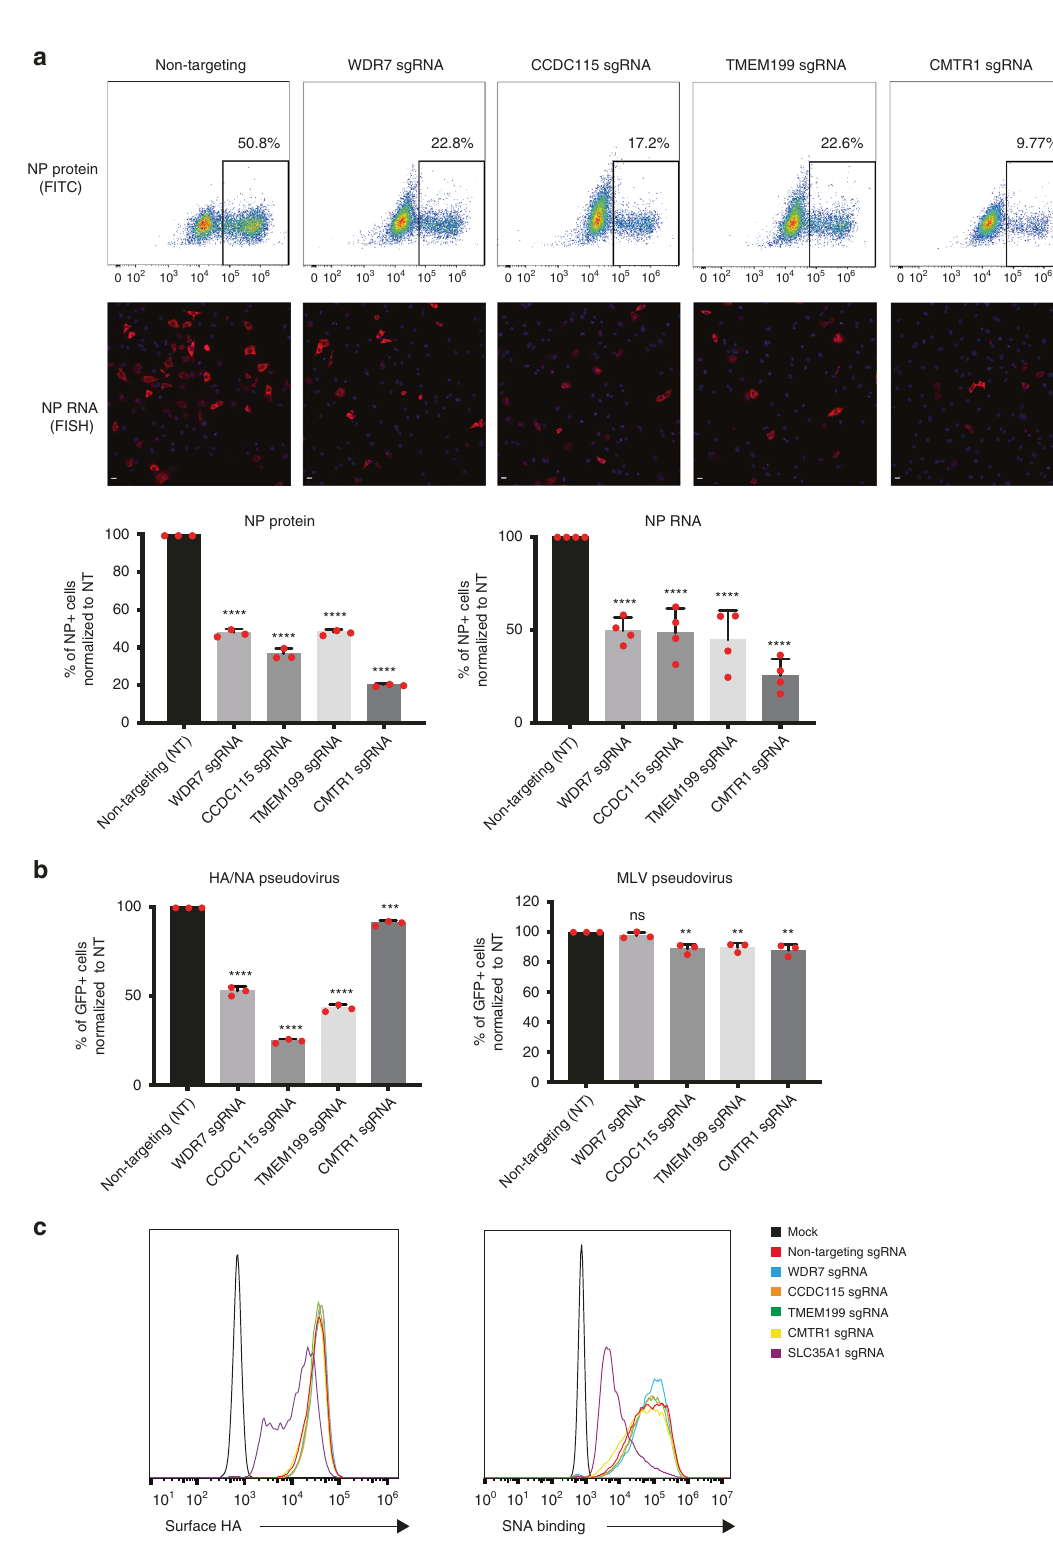
chloroquine and tamoxifen could lead to increased lysotracker red staining due to lysosome adaptation and biogenesis caused by nuclear translocation of transcription factor EB (TFEB) 47,48 (Supplementary Fig. 9A). To test if absence of WDR7, CCDC115 or TMEM199 leads to TFEB translocation and lysosomal biogenesis, we extracted cytosolic and nuclear proteins from WDR7, CCDC115, and TMEM199 polyclonal KO cells